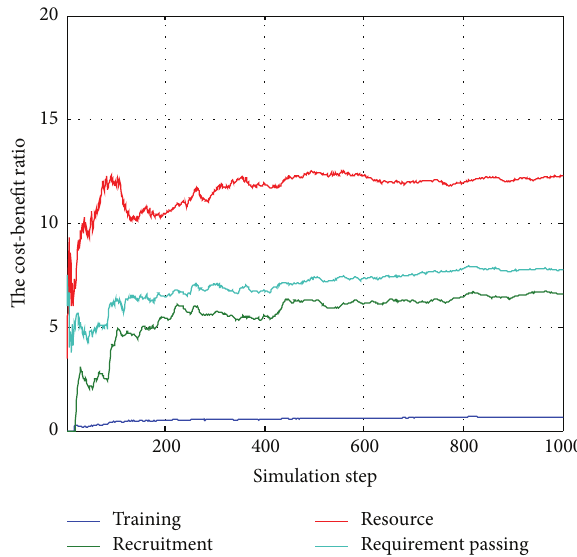
Figure 10: Simulation results of organizational cost-benefit ratio.